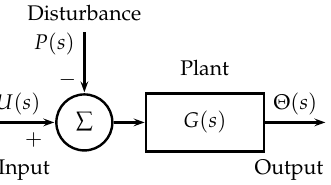
Figure 6. Equivalent block diagram of the plant.